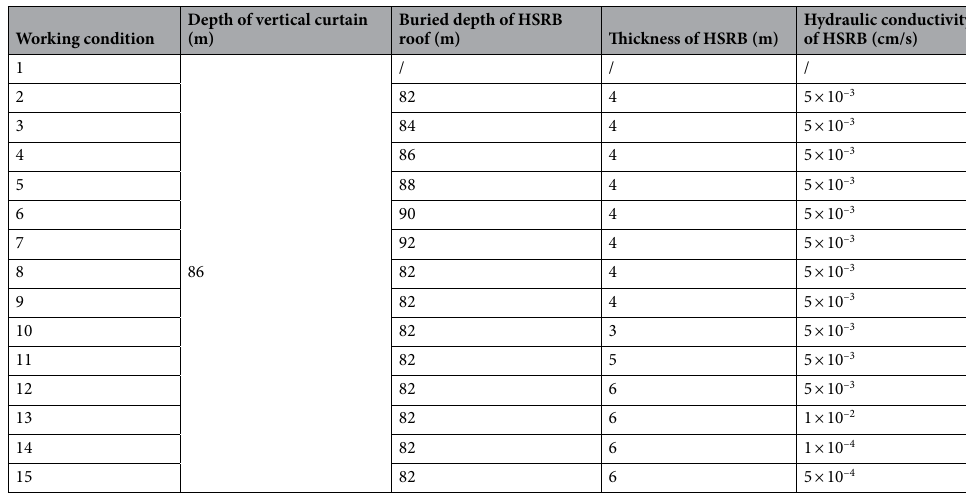
Depth of vertical curtain (m)